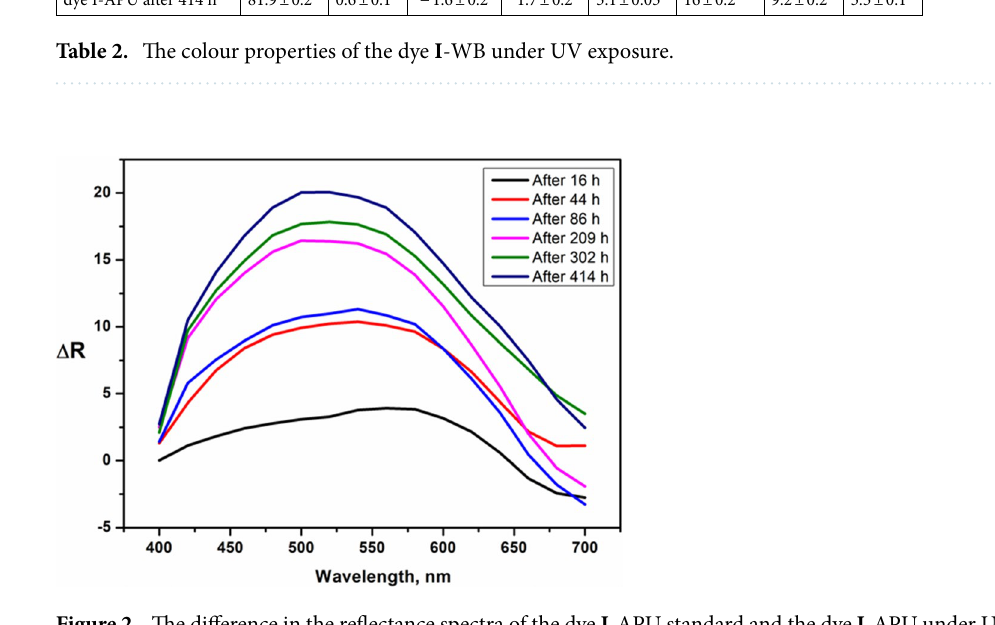
Figure 2. The difference in the reflectance spectra of the dye I -APU standard and the dye I -APU under UV radiation for some periods of